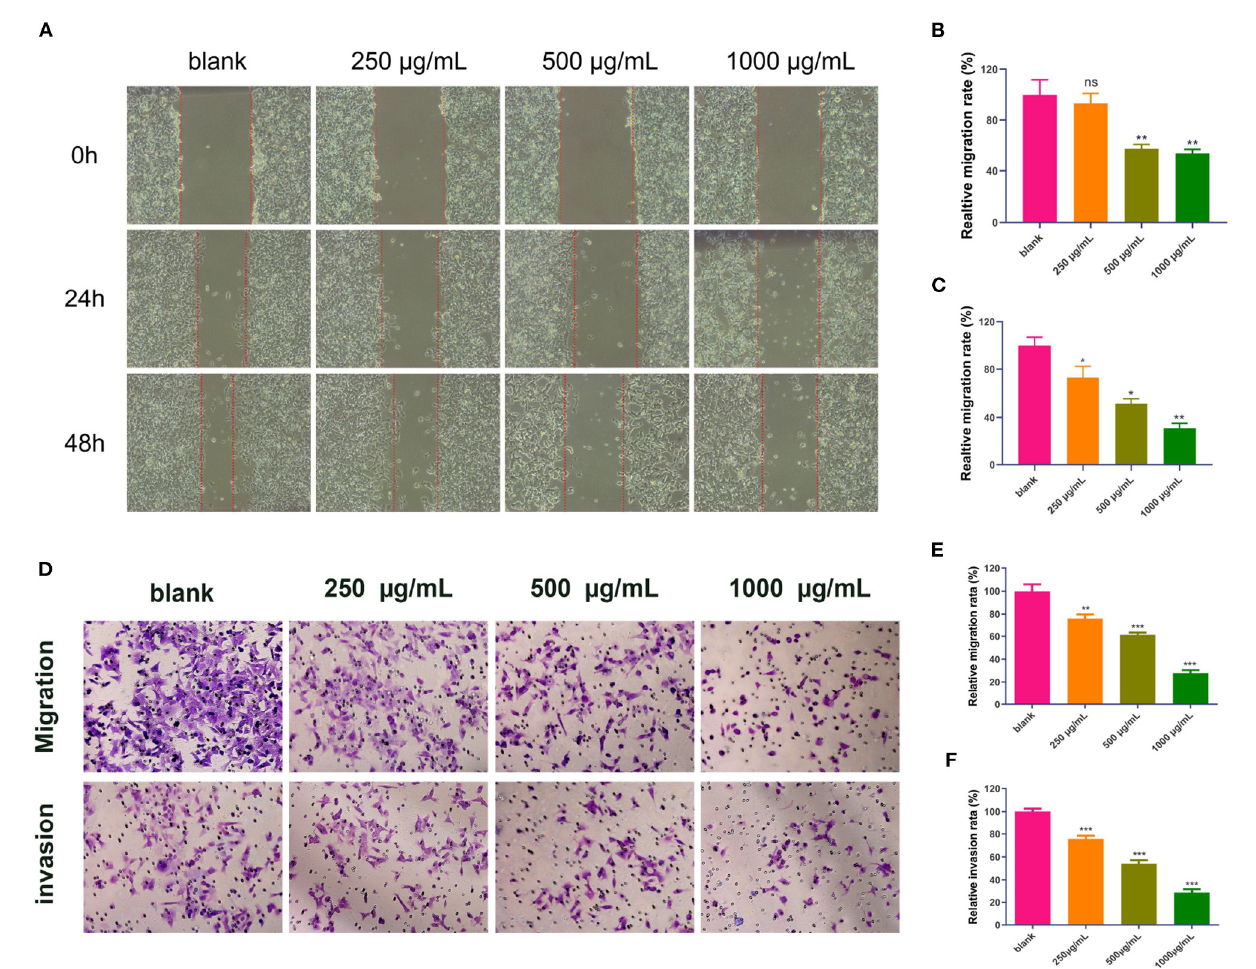
FIGURE 7 | DOME suppresses migration and invasion of Lovo cells. (A) Images of wound healing assay; quantification of wound healing assay in Lovo cells at 24h (B) and 48h (C) ; (D) transwell assay in Lovo cells. (E) quantification of transwell migration assay in Lovo cells; (F) quantification of transwell invasion assay in Lovo cells. The error bars represent SEM (* P < 0.05, ** P < 0.01, *** P < 0.001 , when compared with the blank